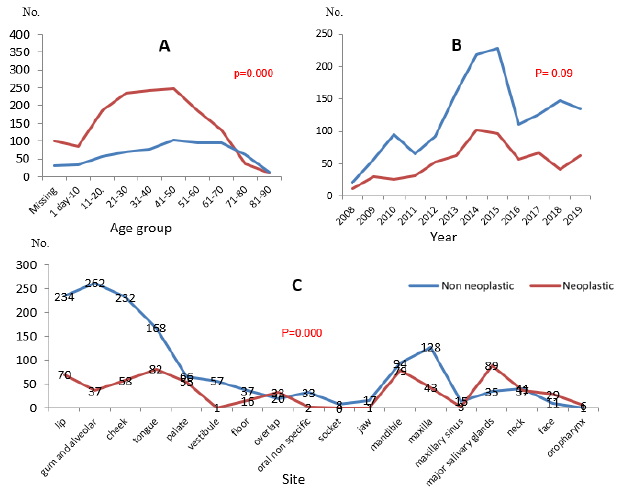
Figure 2 : Frequency distribution of neoplastic and non-neoplastic oral and maxillofacial reported surgical biopsies in Sulaimani city according to the age group (A), years of registration (B), and anatomical site (C). Pearson Chi-Square test P value